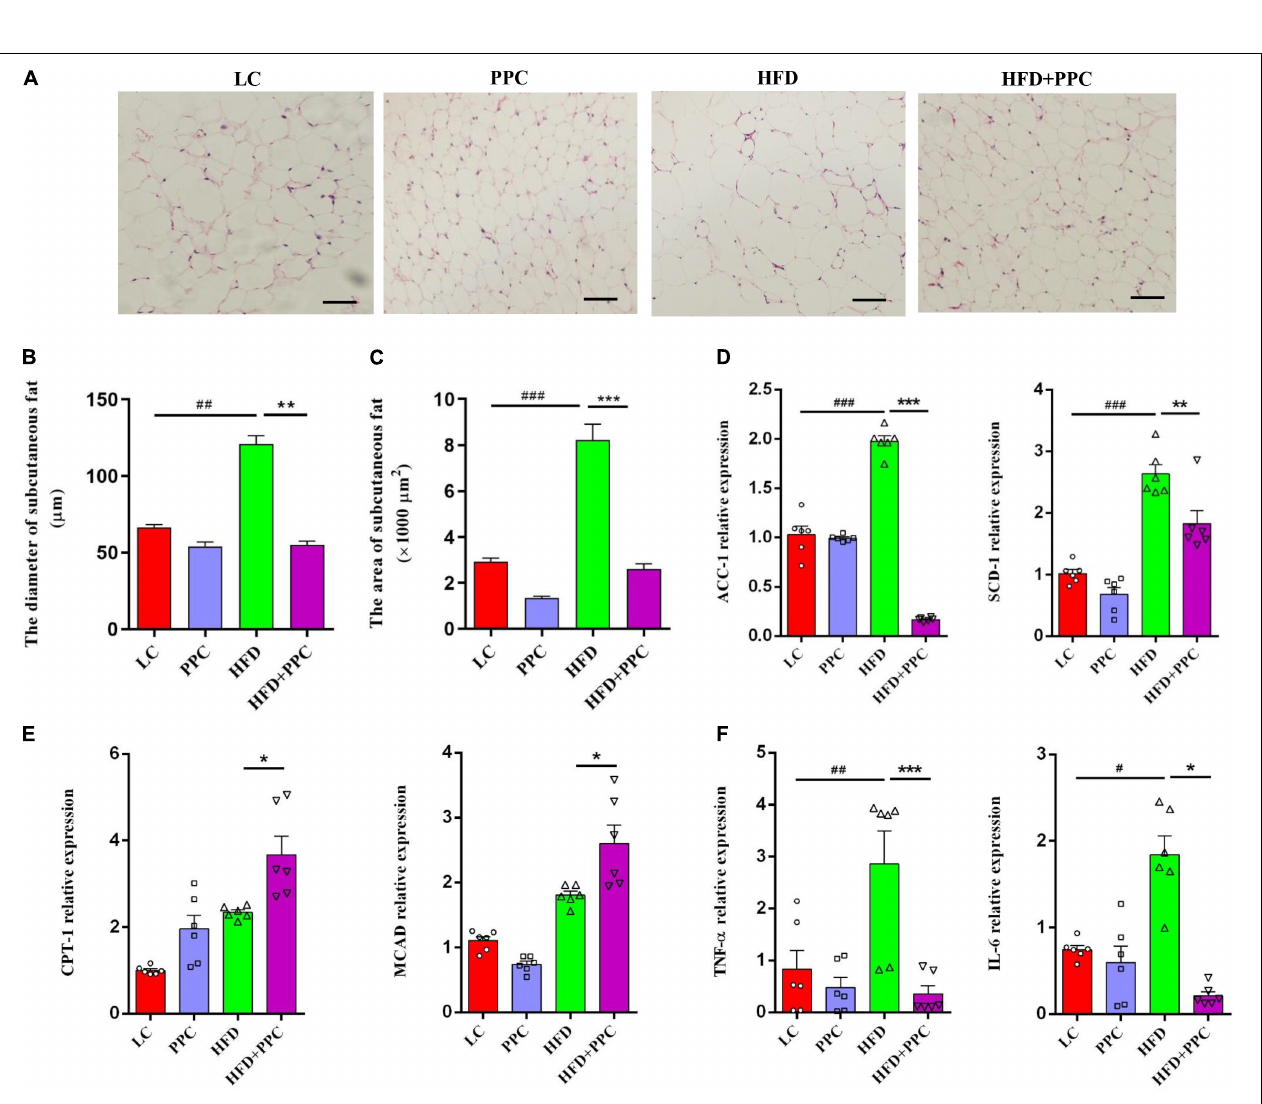
FIGURE 7 | PPC supplementation attenuated the metabolic inflammation via inhibiting pro-inflammatory macrophage polarization in the liver of mice fed by HFD. (A) The expression of genes related to pro-inflammatory macrophage, anti-inflammatory macrophage, and chemokines. n = 3 for each group. (B) Immunohistochemical analysis of F4/80 positive cells in liver. (C) Immunohistochemical analysis of CD206 positive cells in liver. (D) Immunohistochemical analysis of CD11c positive cells in liver. (E) Counting of positive cells via ImageJ. Statistical significance was determined using the ANOVA followed by the post hoc Tukey test for comparisons. Two-tailed Student’s t -test was used for comparison between two groups. Data represent means with SEM. The pound signs indicate statistically significant differences compared to the LC group. ## P < 0.01, ### P < 0.001. Asterisks indicate statistically significant differences compared to the HFD group.